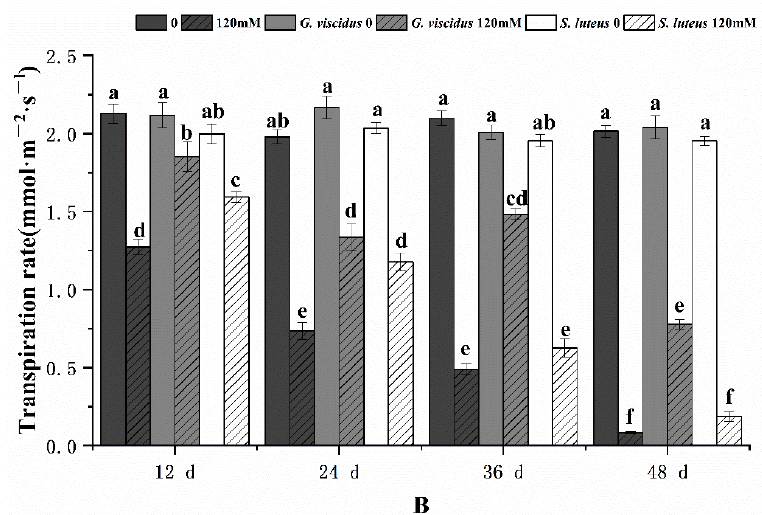
Figure 4. Changes in the net photosynthetic rate ( A ) and transpiration rate ( B ) in ectomycorrhizal seedlings of Q. mongolica under NaCl stress. Bars represent means of five replicates ( ± SD). For each parameter, bars with different letters indicate significant differences among treatments, p ≤ 0.05, following one-way ANOVA.